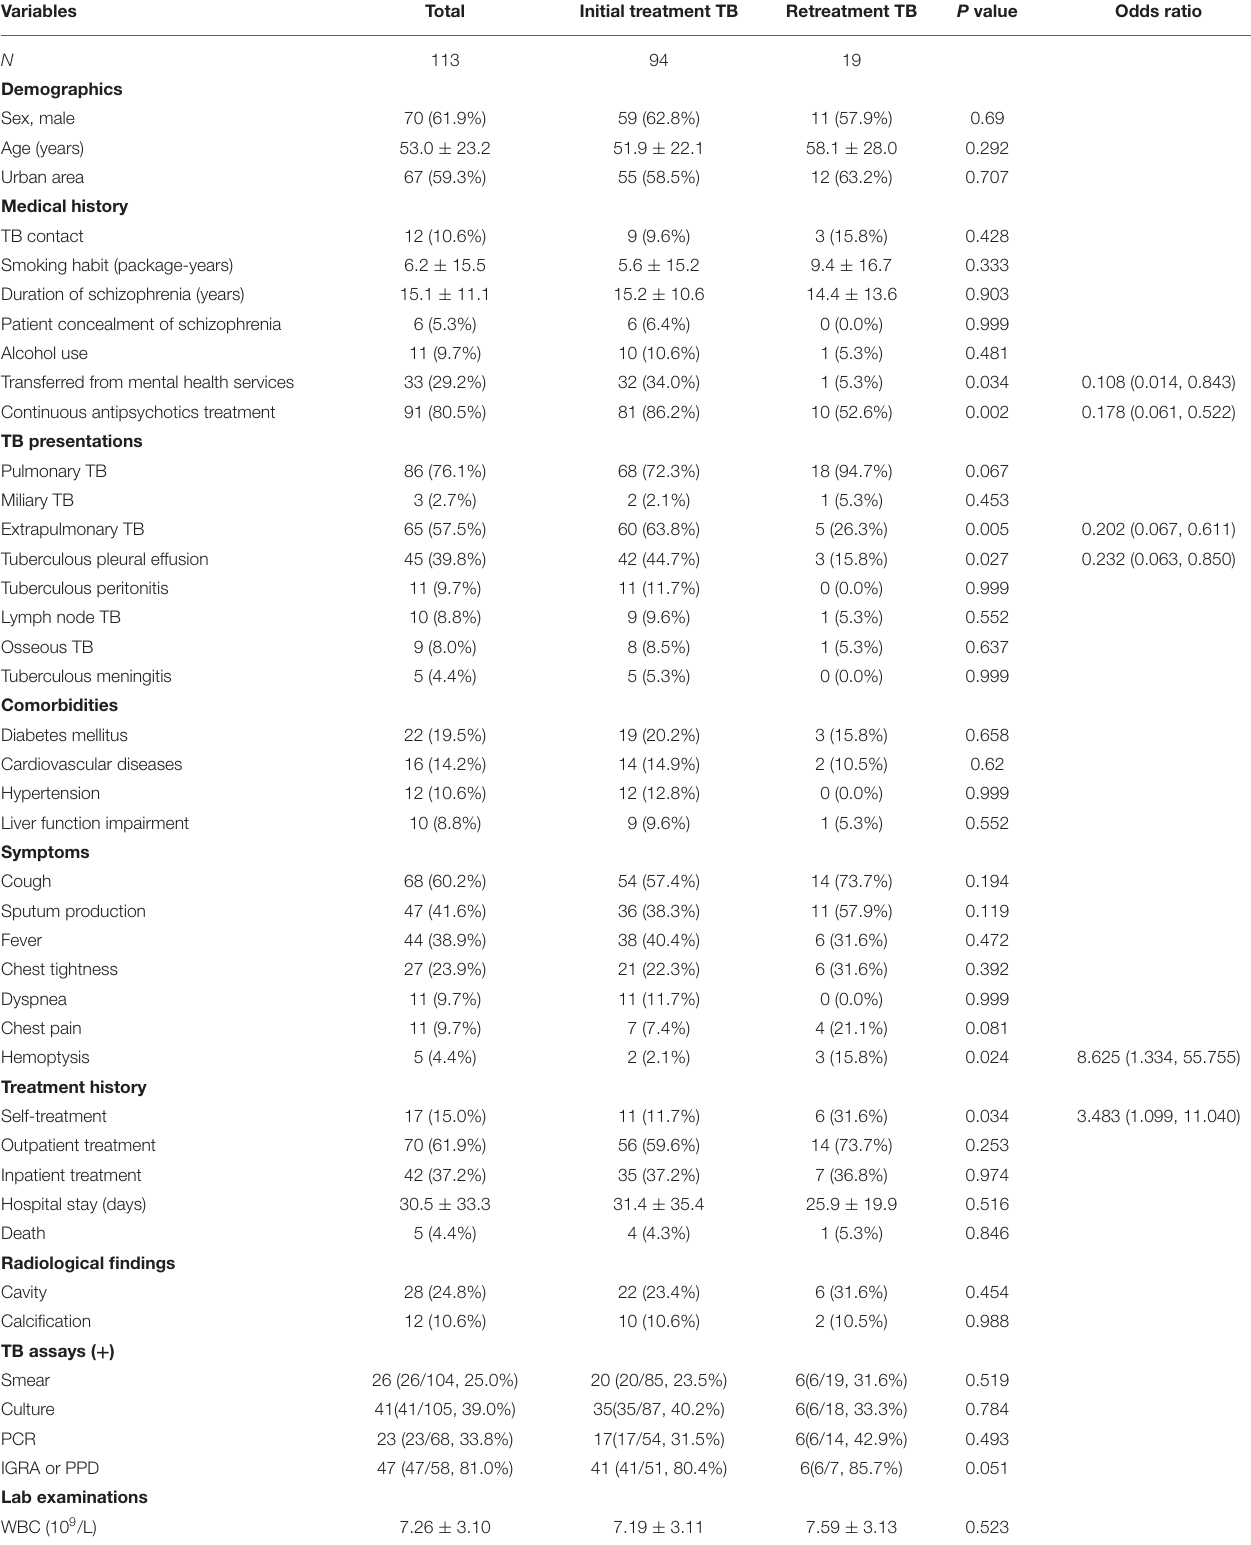
TABLE 1 | The characteristics of schizophrenia patients with initial treatment and retreatment